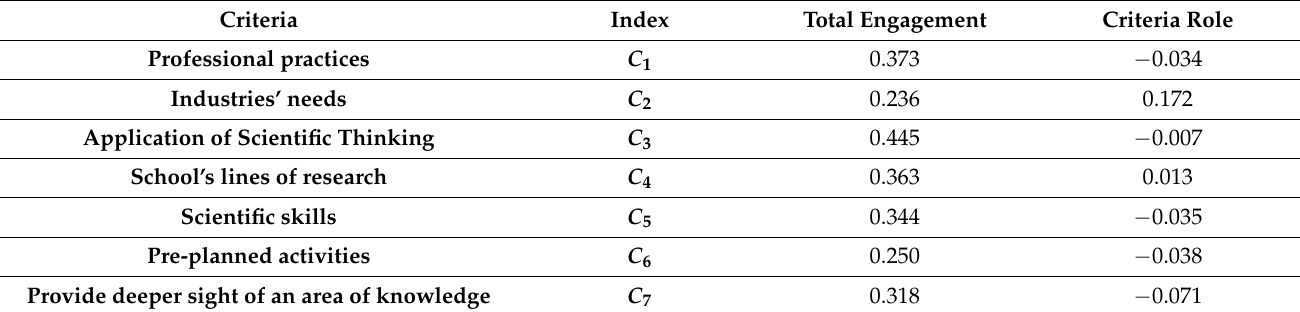
Table 12. Experiment 3 results.